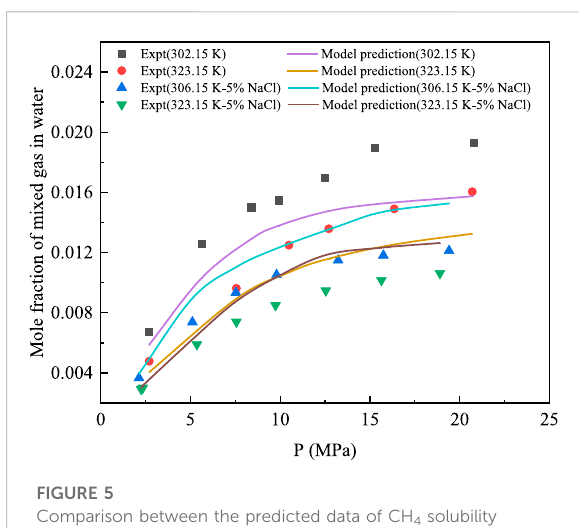
FIGURE 5 Comparison between the predicted data of CH 4 solubility model and the experimental data at 323.15